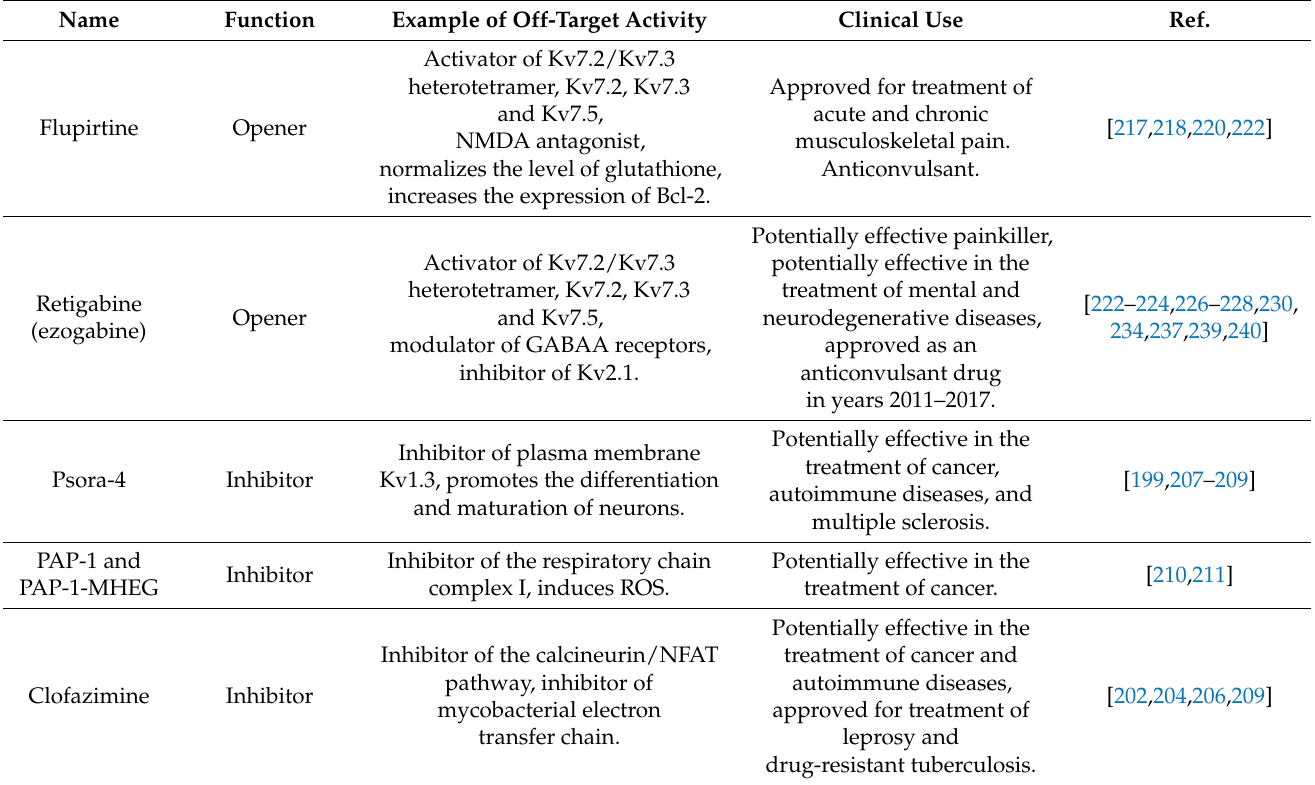
Table 3. Examples of modulators of mitoKv channels, their off-target activity, and clinical